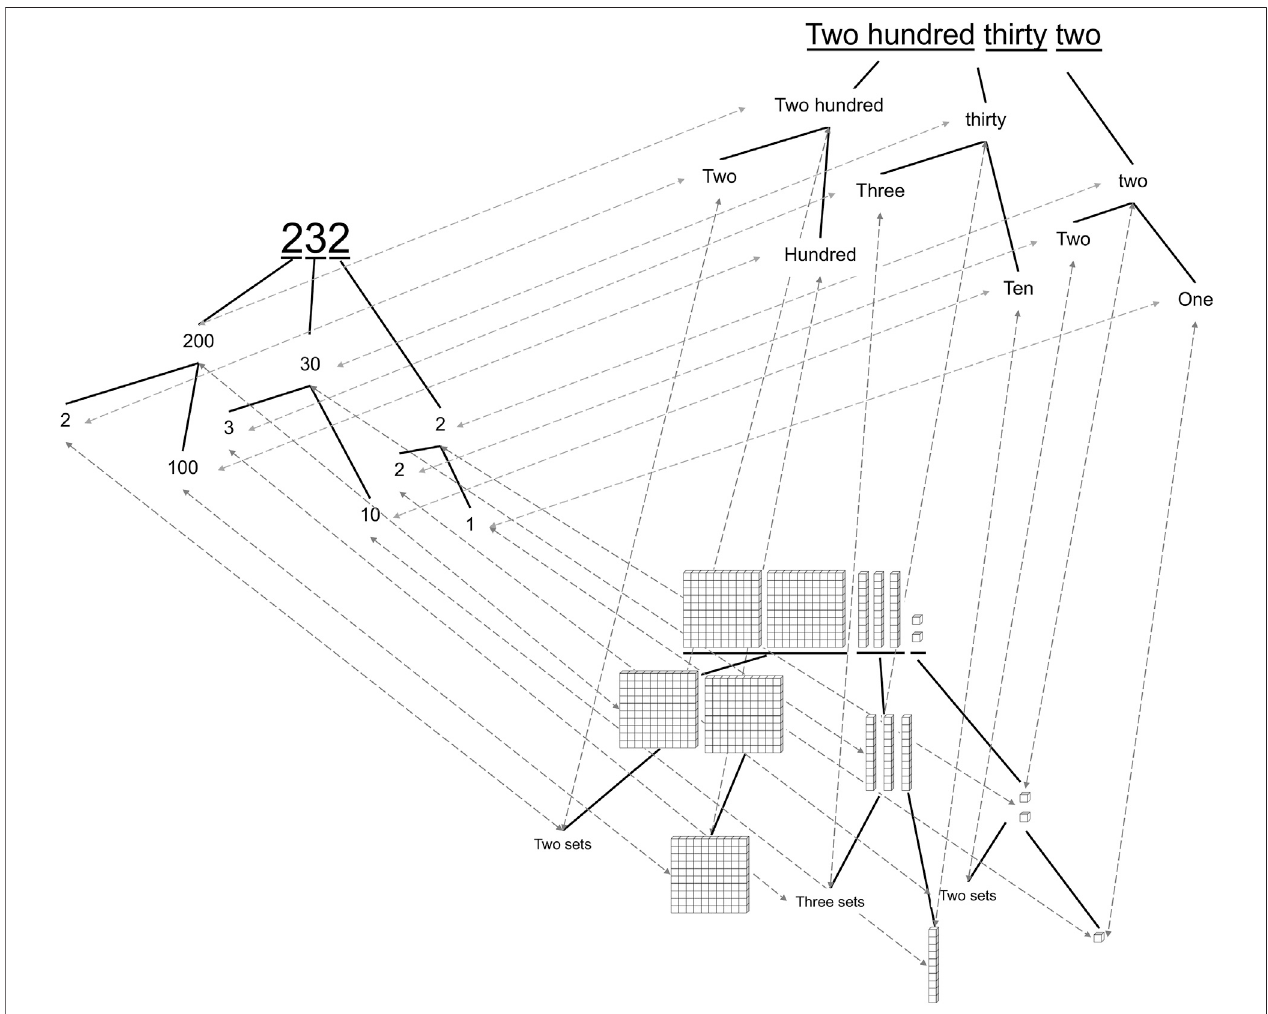
FIGURE 2 | Systems of relational mappings among a written multi-digit number, its corresponding number name, and the base-10 blocks representation of its numericalquantity.Thesolidlineshighlightthestructurewithineachrepresentation,whilethedottedlinesdenotethemyriadrelationalmappingsbetweencorresponding